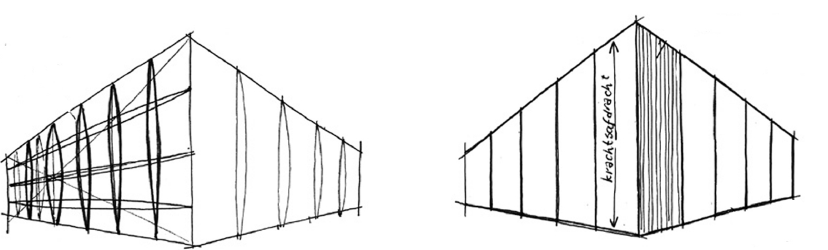
Figure 2: Sketches from brainstorm sessions.